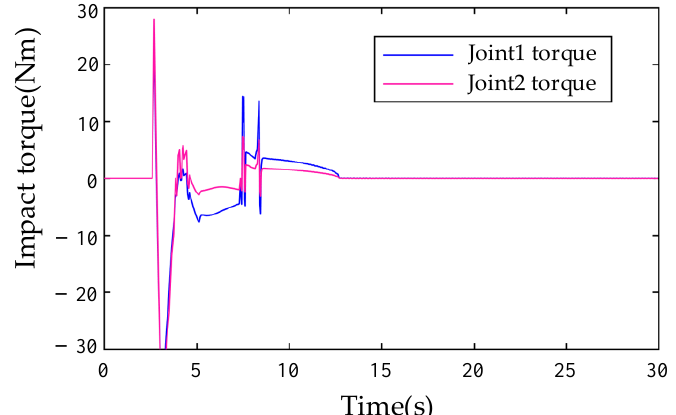
Figure 11. The joint active torque of the spacecraft-manipulator system.